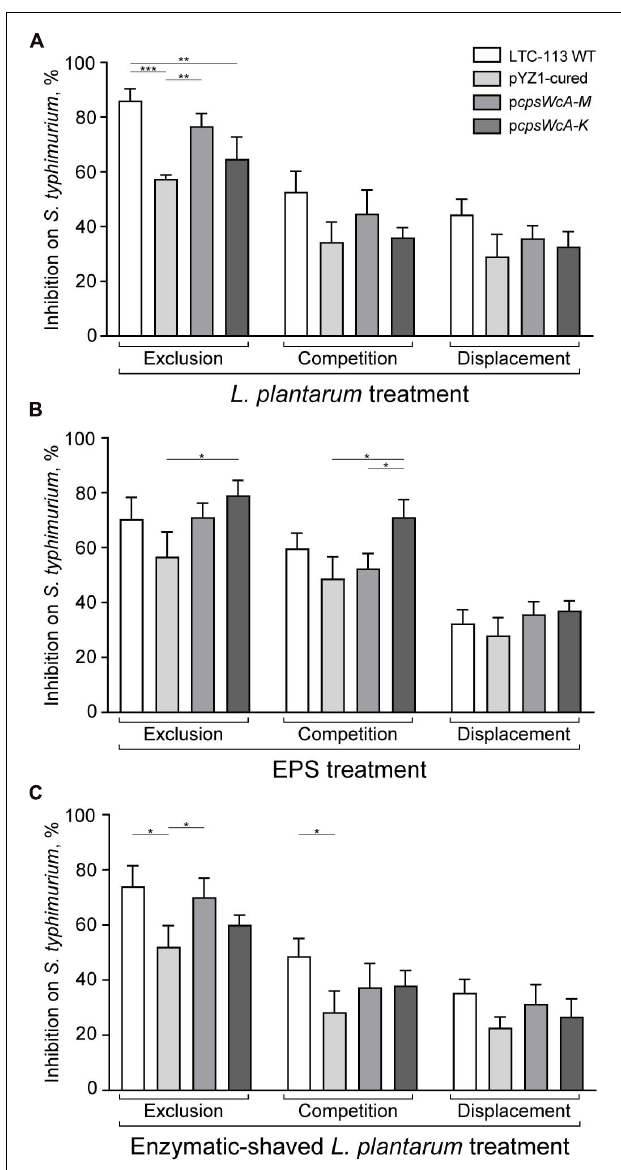
FIGURE 5 | Inhibition on pathogenic S. typhimurium by L. plantarum . (A) The inhibitory activities of LTC-113 and its derivative strains on S. typhimurium in three experimental models, including exclusion, competition, and displacement. (B) Inhibition effect of EPS only. (C) Inhibition effect of trypsin-shaved bacteria. Values represent mean ± SD of the mean; * P < 0.05; ** P < 0.01; *** P <